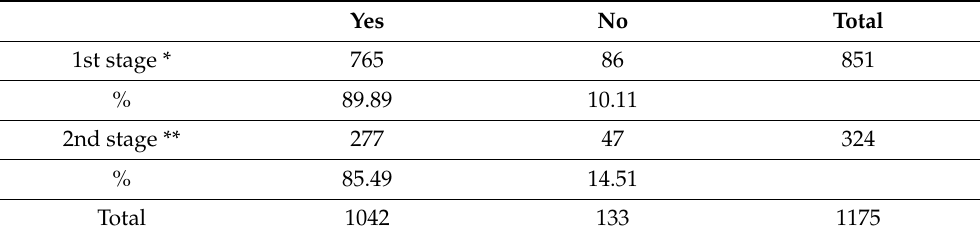
Table 5. Pupils’ responses to the question “Do you own a bicycle and use it as a means of transport or for sport?”, before and after situation caused by COVID-19.